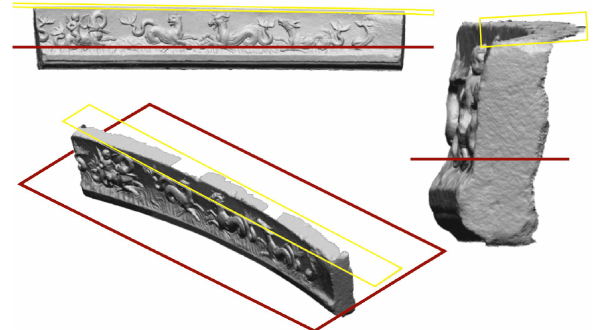
Figure 7. Different sections of the frieze depending on the selected reference plane (examples yellow and red planes)